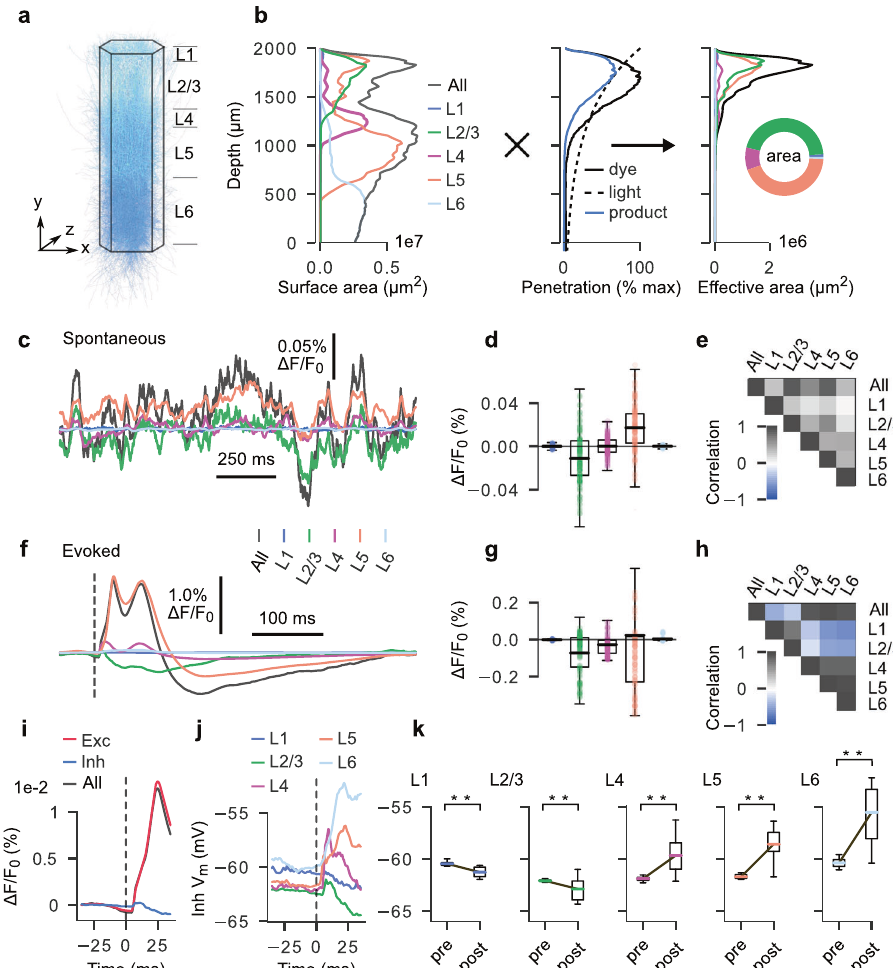
Fig. 3 Fractional contributions to VSDI measurements by layer and cell-type. a – b Surface area contributions for each layer by depth. a Microcircuit, for reference respecting relative layer positions and axis orientation. b Left: raw (unscaled) neurite surface area pro fi les by depth for each layer (20 µ m bins). Middle: depth-dependent scaling prefactors accounting for dye diffusion (solid black line) and light penetration (dashed black line). Solid blue line indicates product. Right: effective surface area pro fi les by depth for each layer (raw surface area b scaled by product of light attenuation and dye diffusion prefactors (blue line, middle panel), 20 µ m bins). c Spatially averaged VSD signal (black) with fractional contribution of each layer (colored) for 1.5 s of spontaneous activity. d Boxplot of fractional layer-wise contribution data in c , illustrating overall spread and polarity of each layer ’ s contributions. Whiskers indicate standard deviation. n = 30,010 time samples acquired over n = 10 independent trials (3001 per trial; 2000 ms to 3500 ms in 0.5 ms steps). Box extends from lower to upper quartile values of the data, with a line at the median. Top and bottom whiskers indicate extent of data up to last datum below Q3 þ 1 : 5 ´ IQR, and last datum above Q1 (cid:2) 1 : 5 ´ IQR, respectively, where Q1 is the 1st quartile, Q3 is the 3rd quartile, and IQR is the interquartile range (Q3 (cid:2) Q1). e Correlation matrix for all traces in c . f Spatially-averaged VSD signal (black) with fractional contribution of each layer (colored) for 500 ms of evoked activity. Plot begins at − 50 ms, stimulus delivered at 0 ms (dashed line). g Same as in d but for evoked activity. n = 30010 time samples acquired over n = 10 independent trials (3001 per trial; 2000 ms to 3500 ms in 0.5 ms steps). Box and whisker de fi nitions same as in e . h Same as in e but for evoked activity. i Fractional contributions of excitatory and inhibitory populations to overall VSD signal, shown over a 50 ms second window spanning 25 ms pre- and 25 ms poststimulus. j Mean membrane potentials computed for inhibitory cell populations in each layer, plotted over the same time window as in i . k Boxplots depicting the difference between pre- and poststimulus membrane potentials for inhibitory cell populations in each layer. Boxplots in each panel were calculated using the 25 ms pre- and poststimulus periods referred to in i and j , ** : p < 1e-10, paired sample t test (two-sided). n = 350 time samples acquired over n = 1 trial (data for each time point calculated by averaging over inhibitory cell voltages per layer). Box and whisker de fi nitions same as in e poststimulus window while L2/3 tended to hyperpolarize, indi- several columns slightly alters the lateral distributions of neurites, cating differential, layer-speci fi c roles during stimulus-driven and accounts for the differences in peak activity pro fi les responses. Analysis of the correlations between layer contribu- (monophasic vs. biphasic) and peak amplitudes (~2.5% vs. ~1%) tions supports this conclusion, showing anticorrelated activity apparent in Figs. 2b and 3f. between super fi cial and deep layers (Fig. 3h). Finally, we note that Morphological reconstructions indicate that the dendritic these experiments (Fig. 3) were conducted in an isolated NMC arbors of inhibitory neurons tend to be spatially con fi ned relative column. In contrast, our analysis of cortical activation spread to their excitatory counterparts (Fig. 1b; red: dendrites, blue: (Fig. 2) was computed in a mosaic concatenation of seven NMCs axons), which may in fl uence their respective contributions to the to allow suf fi cient surface area for signal spread. Concatenating VSDI signal. Thus, we also decomposed VSD fl uorescence into